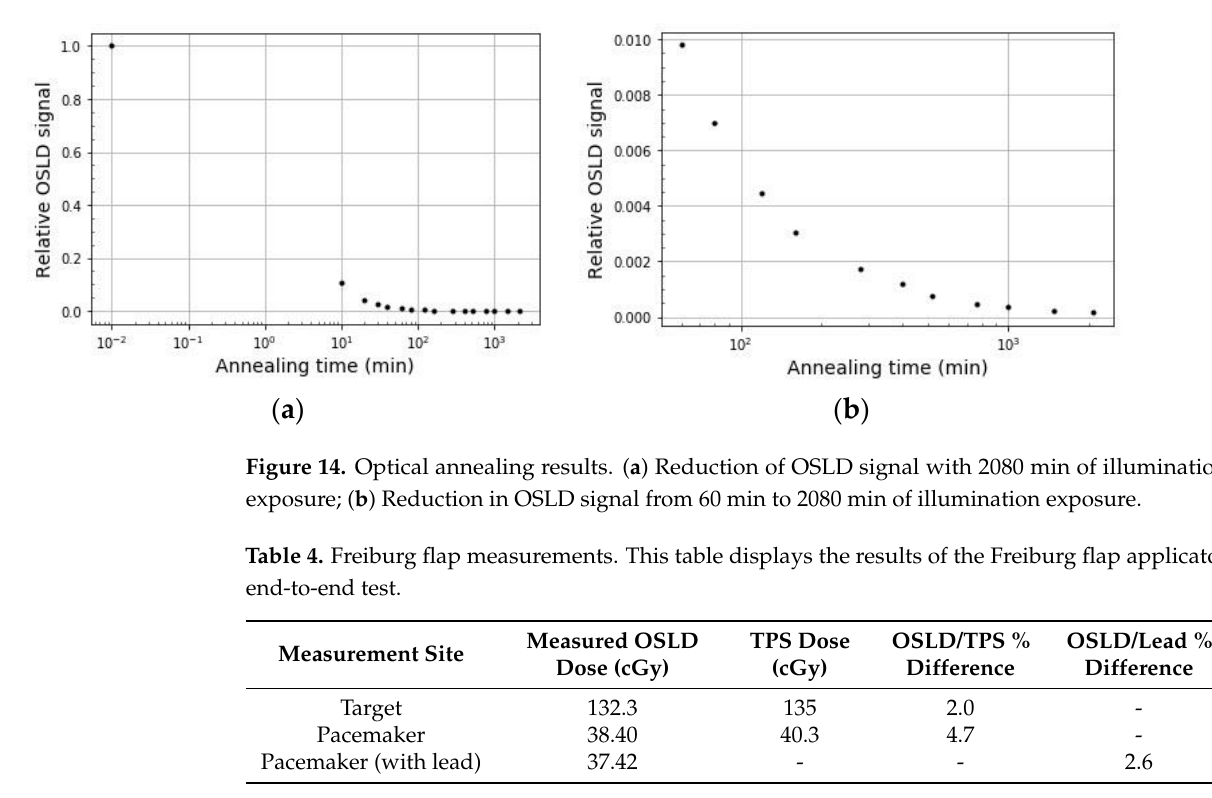
12 Figure 13. Readout depletion results. The depletion of OSLD signal with consecutive readouts. The data from all nine irradiated OSLDs is overlayed, and the red dashed line represents the linear re- gression applied to the data, which has an intercept of 1.002, a slope of −0 .0005/readout, and a stand- ard deviation of the residuals of 0.00675. 3.6. Optical Annealing The initial dose of each OSLD ranged from 1.429 cGy to 769.1 cGy. The OSLDs were optically annealed for a total time of 2080 min, and readings were conducted periodically throughout. Each OSLD was closed and kept in the dark after each illumination period before readout to prevent the detection of phosphorescent light [21]. The relationship be- tween optical annealing time and the remaining signal is displayed in Figure 14. It can be seen that 90% of the OSLD signal is removed in the first 10 min of light exposure. Further, the OSLD signal reaches a plateau around 1500 min (approximately 24 h) at a signal of